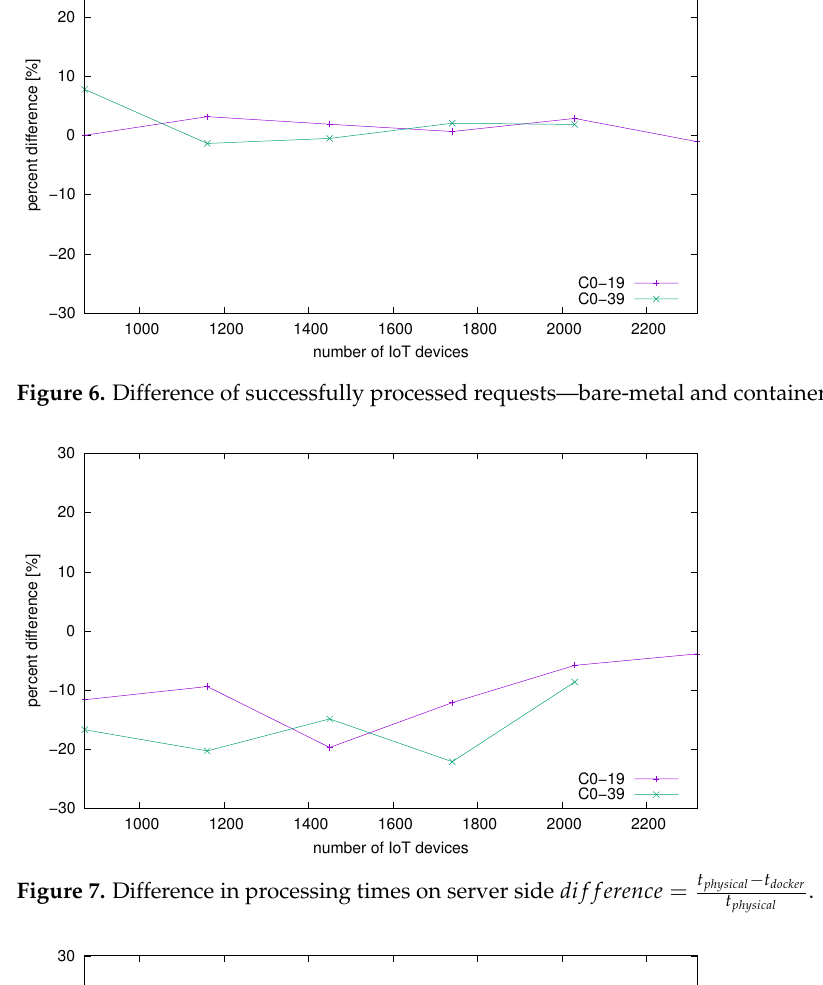
Figure 7. Difference in processing times on server side dif ference = t physical